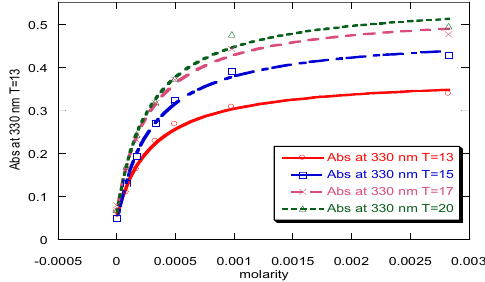
Figure 3. The plots of Abs vs. molarities of the ligand for cis -[Pt( p -ol)